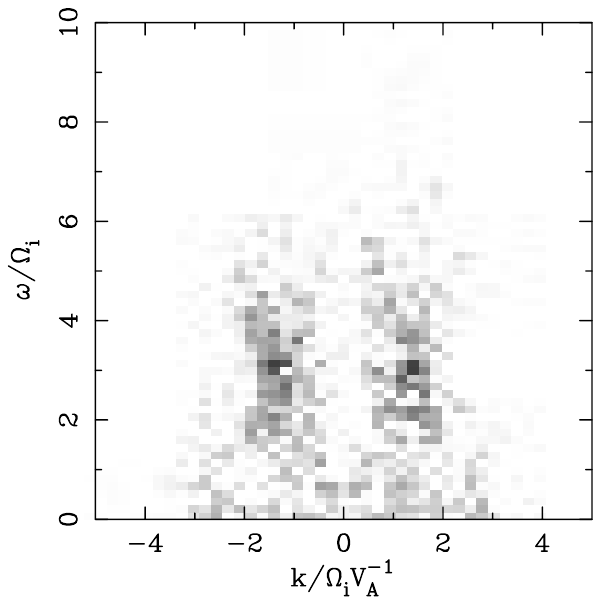
Fig. 4. Graph plotting the power in the Fourier Transform of Fig. 3c against k along the maximum power best fit dispersion relation.